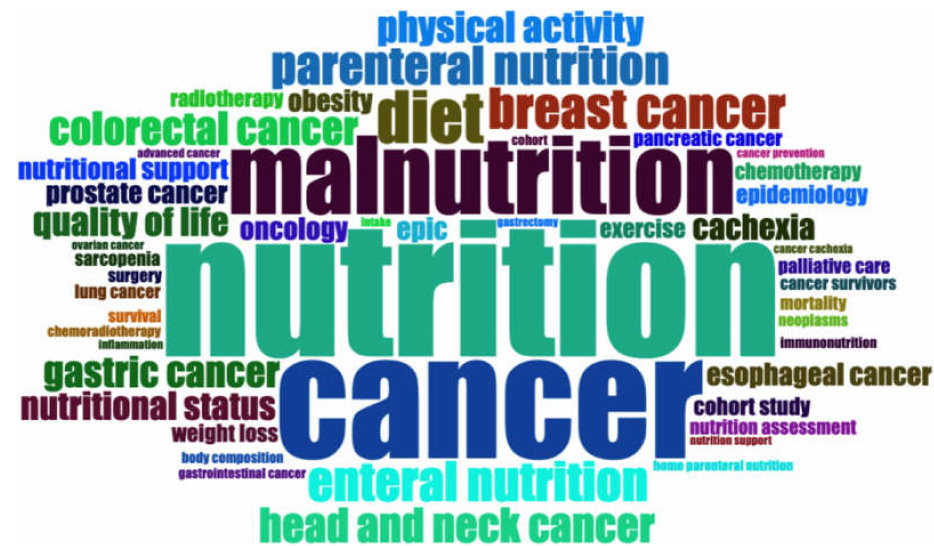
Figure 4. The word-cloud analysis on nutrition and cancer from 2011 to